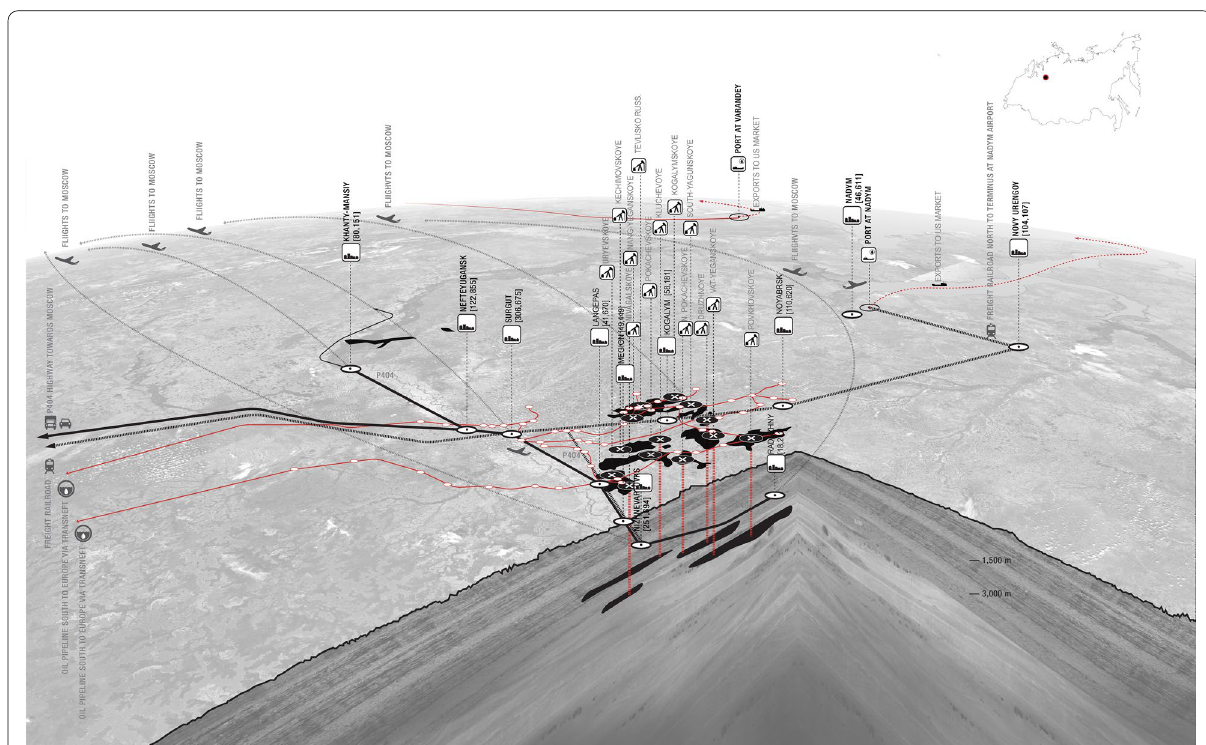
Fig. 4 Urban fabric of the Khanty-Mansyisk oil region, showing the association between new settlements and areas of resource extraction. Image credits: Salgueiro Barrio and O’Shea. Image Sources: Drawings 4: Satellite Imagery: Google Earth Pro. Cities: ESRI, Wikipedia, Google Earth Pro. Transportation Networks: ESRI, Google Earth Pro. Oil production in general:“The Oil Converter.” <http:// watd. wuthe ring- heigh ts. co. uk/ subpa ges/ oilco nvert er. html>“To Privatise or not to Privatise.” The Economist. January 19, 2013. http://www.economist.com/news/europe/21569756-russi an-government-has-ambitious-plans-privatisationsupposedly-privatise-or-not?zid Energy Information Administration. http://www.eia.gov/countries/cab.cfm?fips Administration. <http:// www. eia. gov/ count ries/ count ry- data. cfm? fips